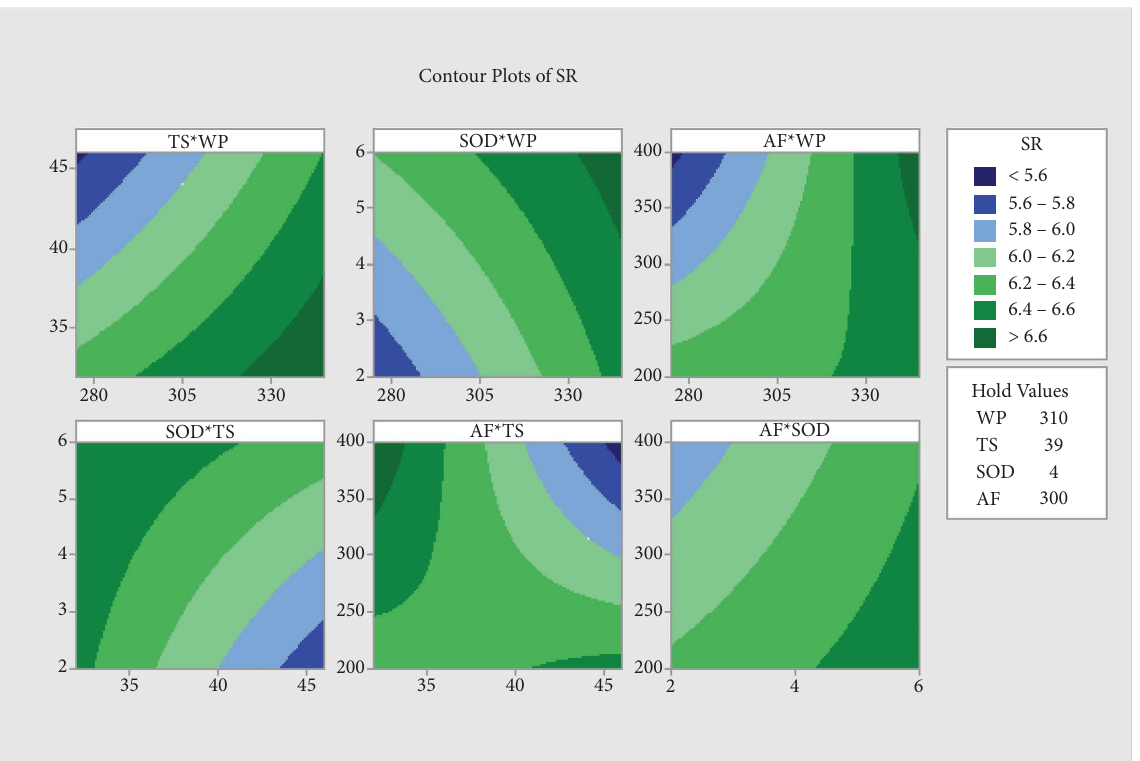
Figure 2: Contour interactions for surface roughness.